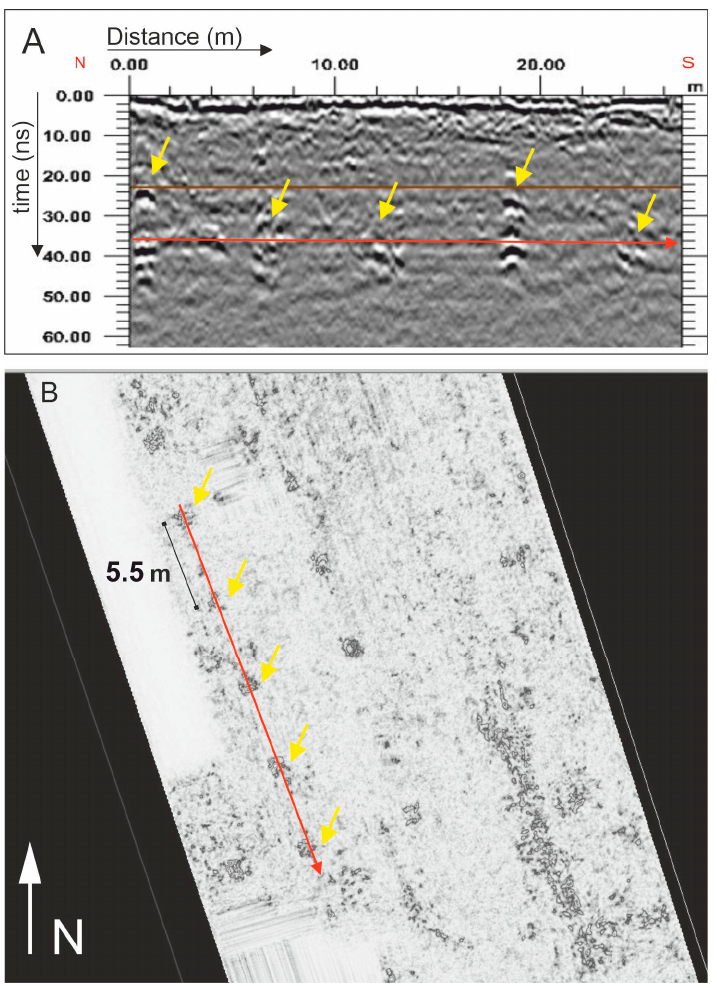
Figure 4. Comparison between a 2-D profile ( A ) and 3-D analysis of the time-slice at 35 ns of the 3-D GPR volume ( B ) (location in Figure 2).